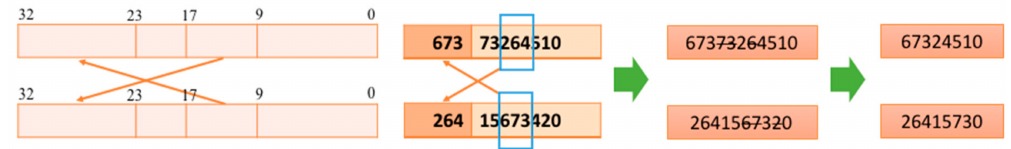
Figure 5. Crossover process in